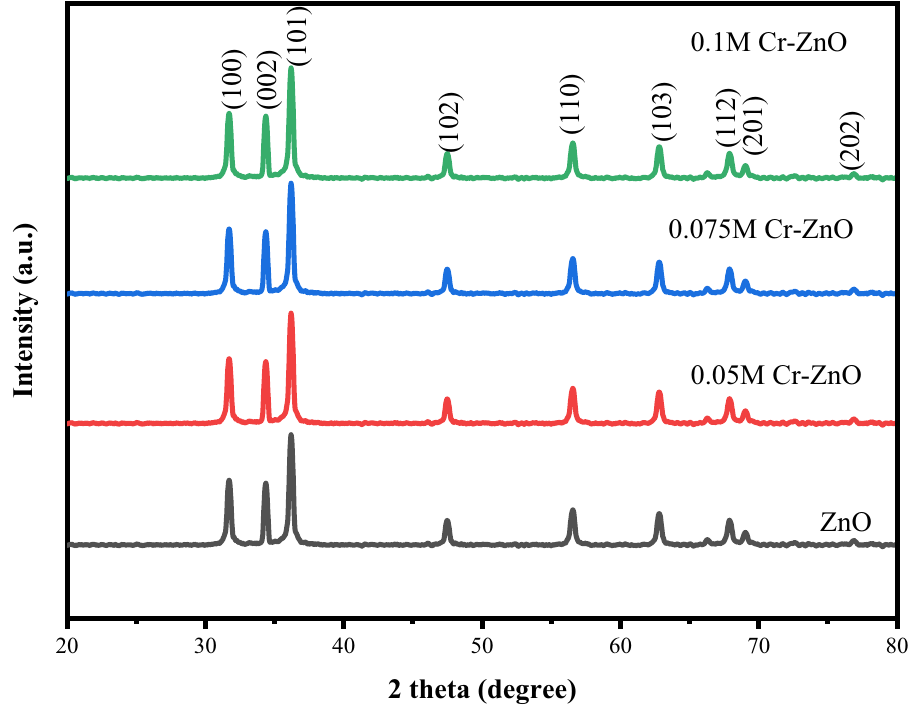
Fig. 2 XRD patterns for ZnO, and Cr doped ZnO nanopar- ticles